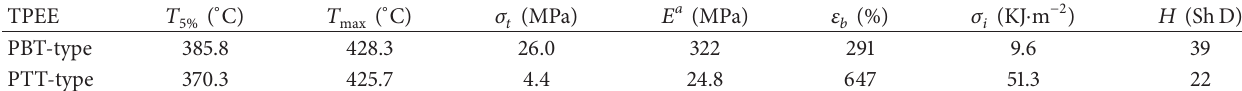
Table 6: TG parameters and mechanical properties for PBT-type and PTT-type TPEE.